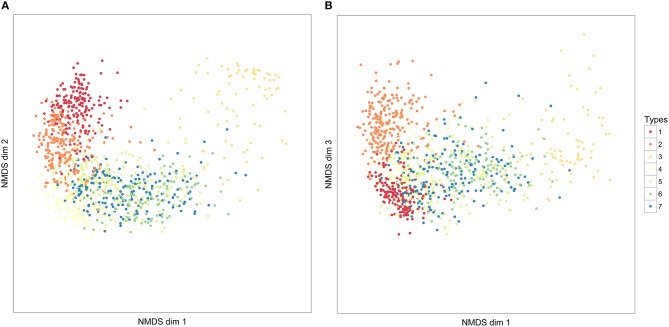
The distribution of seven syllable clusters across three NMDS dimensions. Each point represents an individual syllable. The closer syllables are to each other in these dimensions, the more similar they have been judged in similarity, according to our DTW comparison of syllables. The values in NMDS dimensions are not meaningful, and following convention, axes have not been labeled. (A) NMDS dimensions 1 and 2; (B) NMDS dimensions 2 and 3.